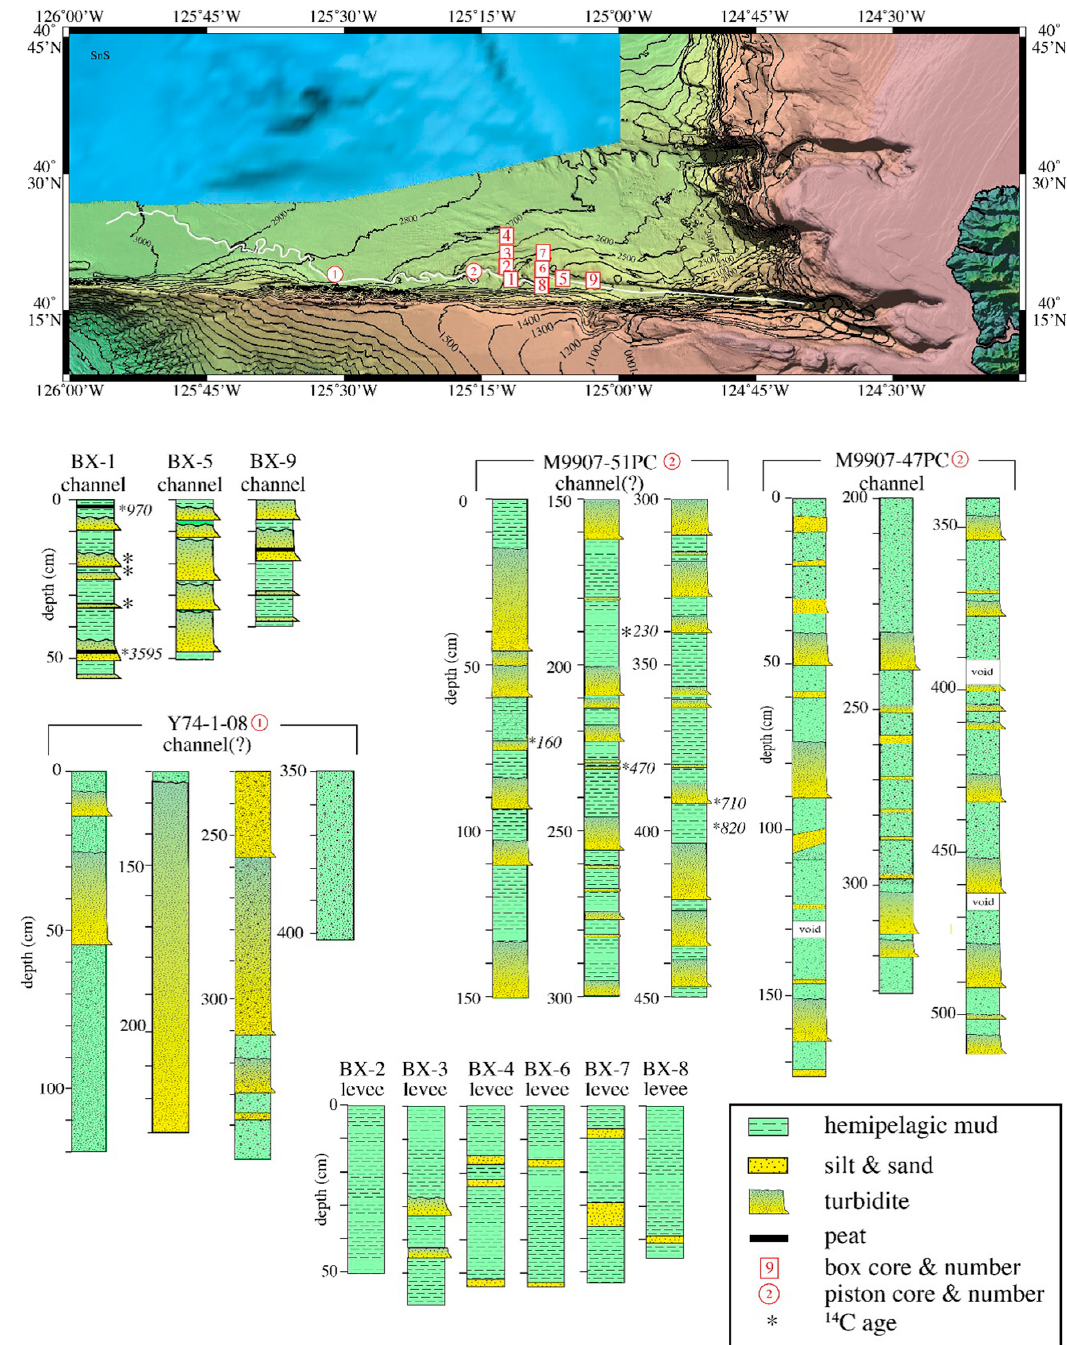
Figure 15. Location map of piston (circles) and box (squares) cores from within the channel and the north levee of Mendocino Channel. Numbers within the symbols indicate the core number in the core descriptions below the map. BX indicates a box core and the other cores are piston cores. Piston core